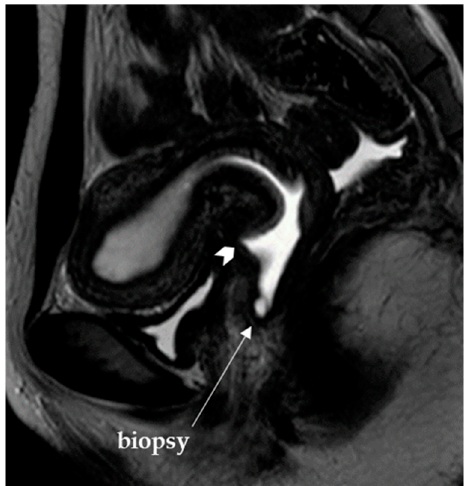
Figure 2. The sagittal T2-weighted magnetic resonance image shows a definite contour of the cervix (arrowhead), suggesting vaginal agenesis with fluid collection in Patient 15 (Table 2). However, the intraoperative biopsy, which was performed at the caudal leading edge (arrow), revealed the presence of cervical gland and stroma material.